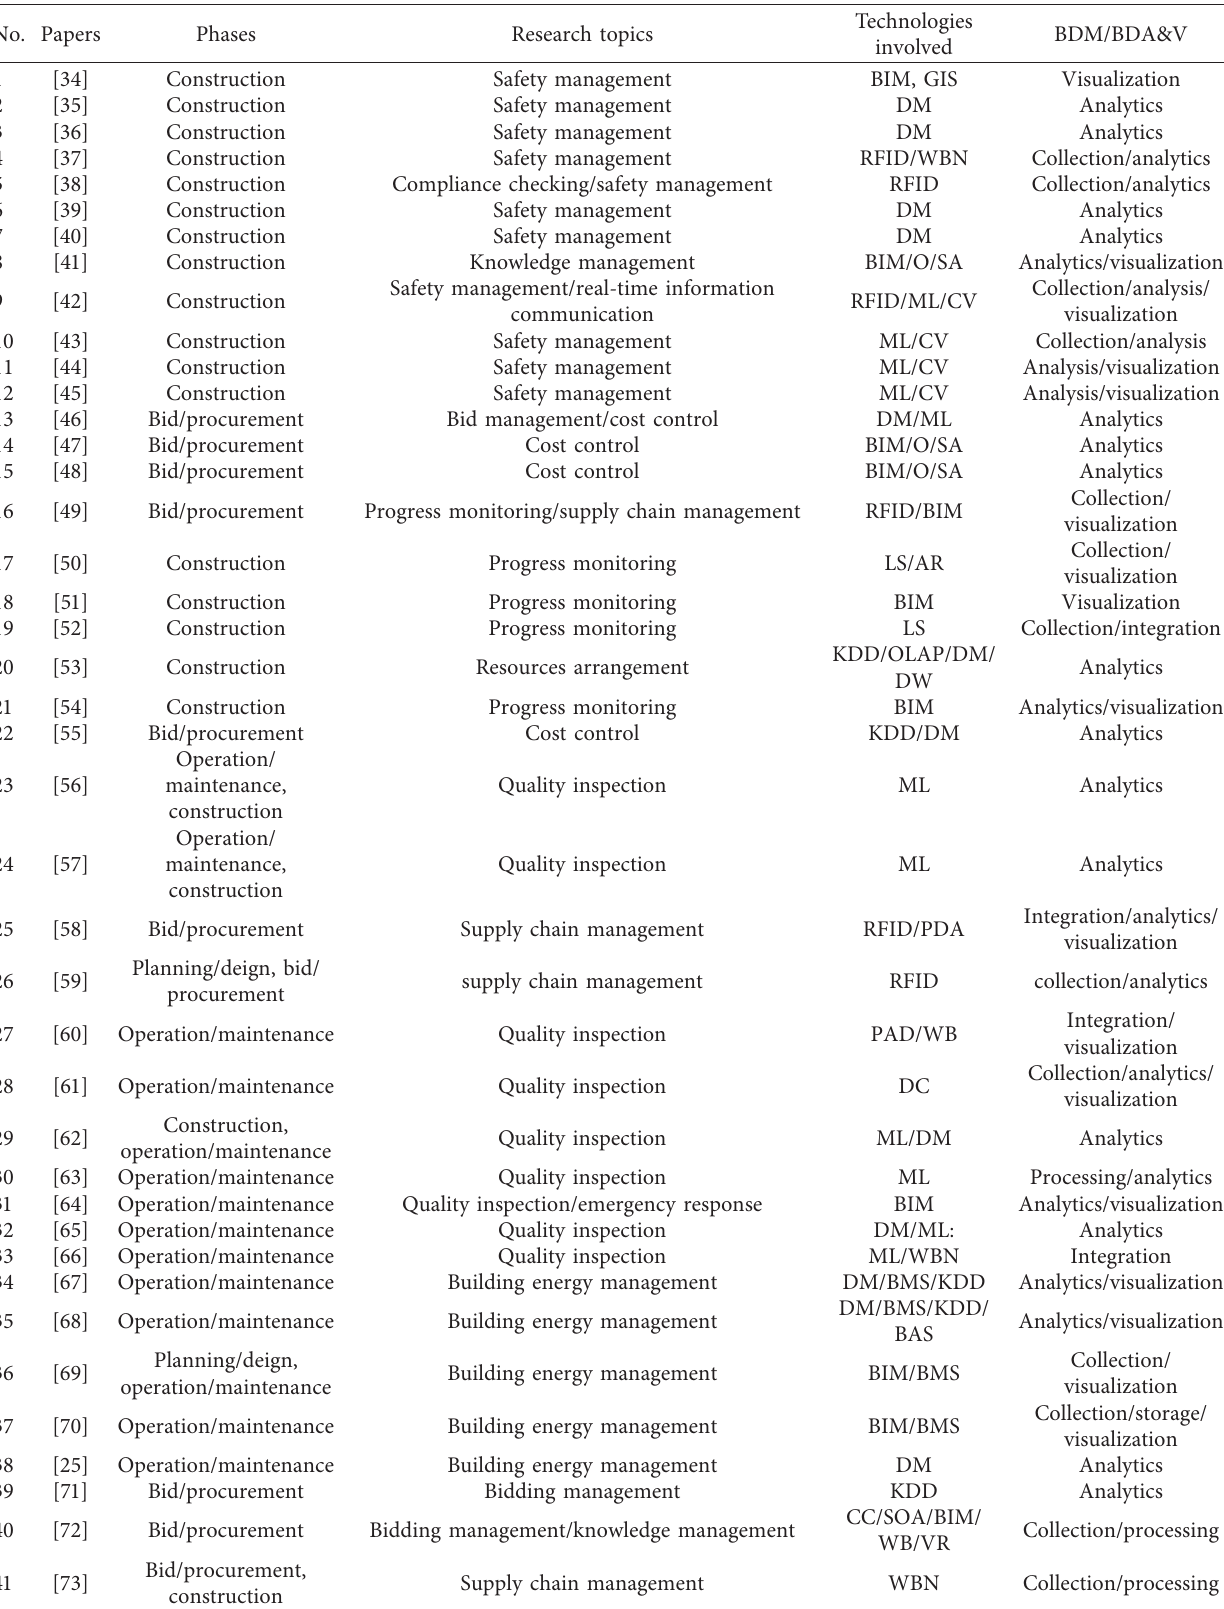
Table 2: A summary of the collected